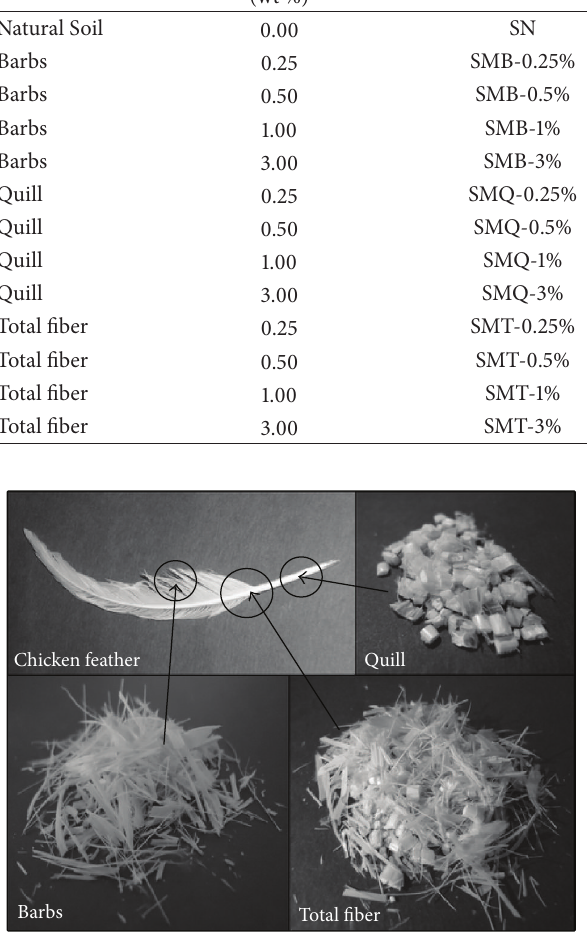
Figure 1: Kinds of feather segments: quill, barbs, and partially cut feathers (total fiber).